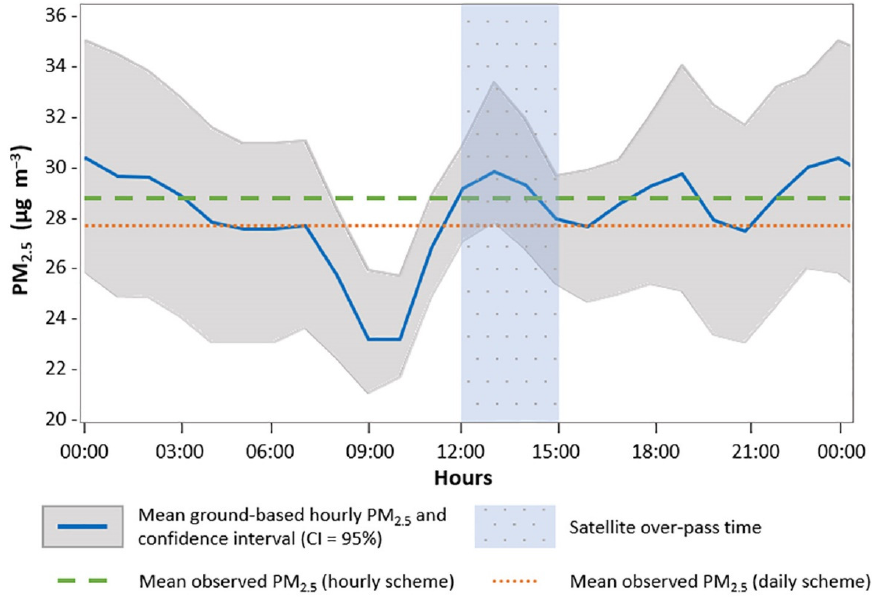
Figure 7. Hourly ground-based PM 2.5 concentrations averaged for the same days and domain cov- ered by the best